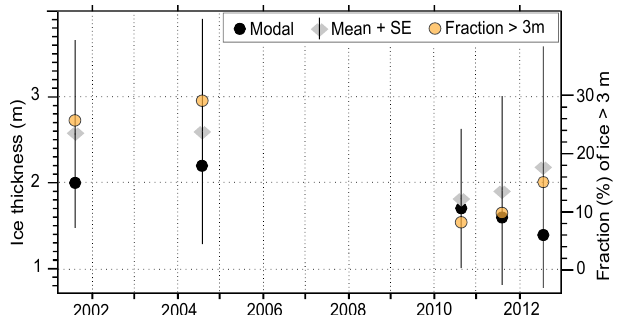
Figure 4. Mean (gray) plus standard deviation (black lines) and modal (black circles) EM ice thickness (ice plus snow (0.1m) thick- ness) obtained in the Fram Strait region between 2001 and 2012 (left axis). The fraction of ice thicker than 3m (right axis) is represented by orange circles. The locations of the performed survey flights is shown in Fig. 1.